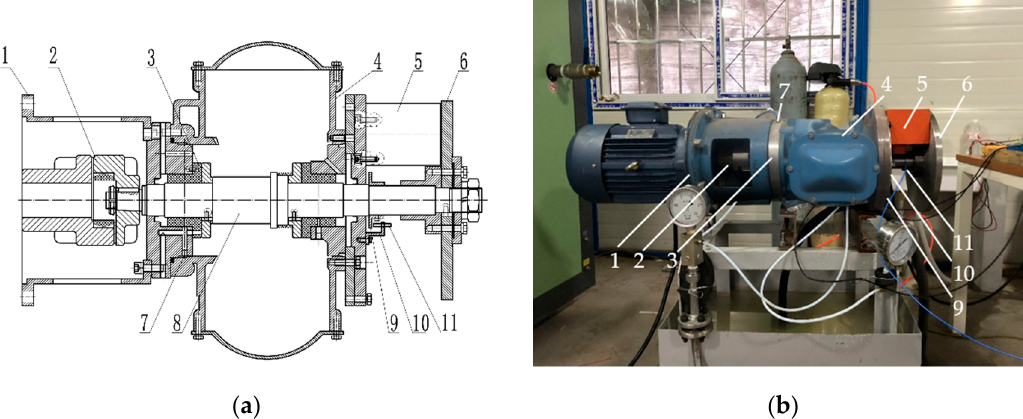
Figure 8. Test rig of water-lubricated HTB of star wheel shaft (developed by author): ( a ) layout of test rig arrangement;